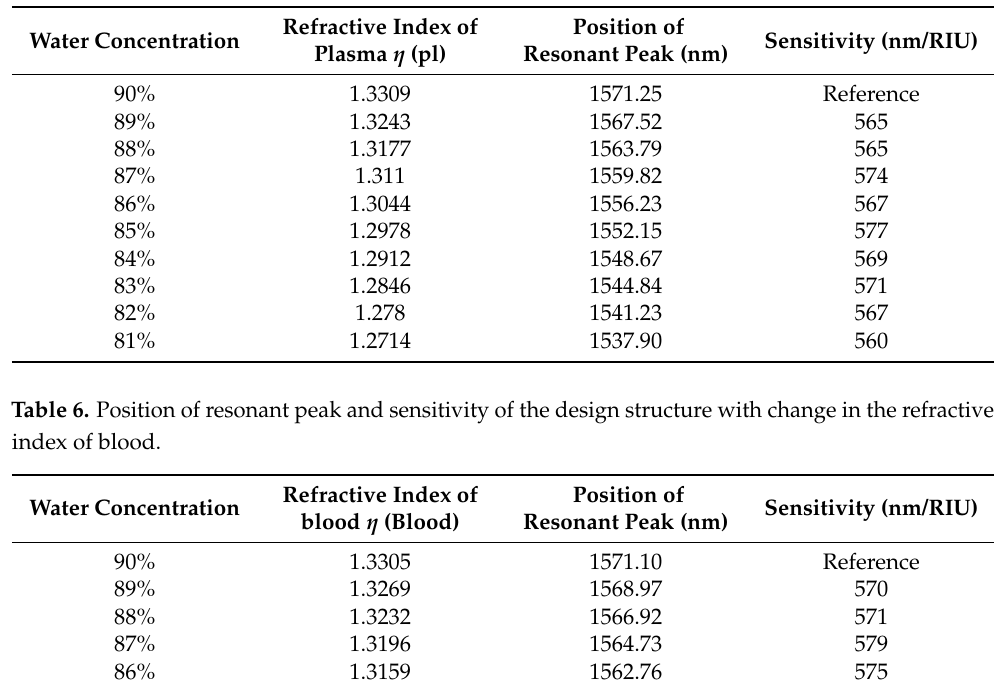
Table 5. Position of resonant peak and sensitivity of the design structure with the change of refractive index of plasma.